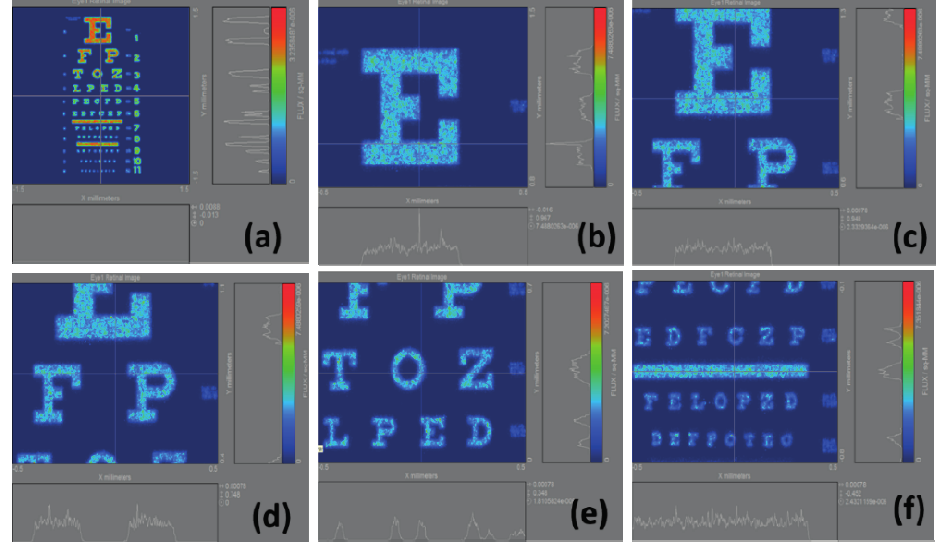
Figure 3. Imaging results of different regions selected in the Snellen chart calculated under standard normal vision conditions. ( a ) a whole location; ( b ) partial location: E; ( c ) partial location: E, F, and P; ( d ) partial location: E, F, P, T, O and Z; ( e ) partial location: F, P, T, O, Z, L, P, E and D; ( f ) partial location: lines 5–8 in the Snellen